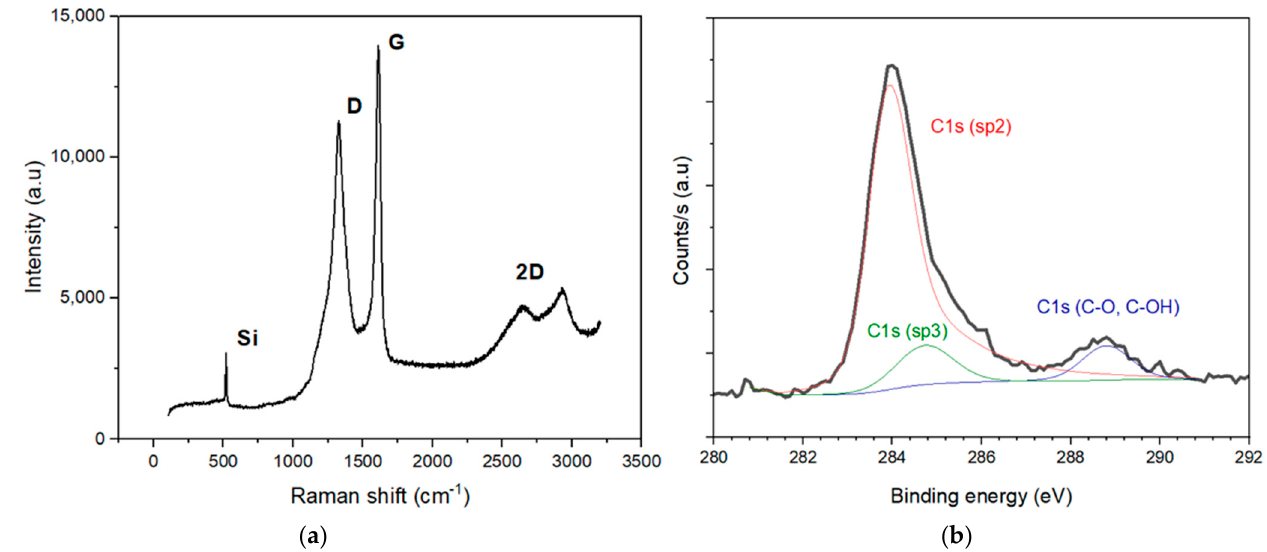
Figure 6. Spectroscopy analyses: ( a ) Raman spectrum of G-PSi-8 and ( b ) XPS analysis of G-PSi-8. XPS analyses were carried out to provide information on the presence of an oxide on the surface after graphene deposition. The XPS analysis (monochromatic source, K α Al (1486.6 eV), with a detection energy resolution of less than 0.1 eV) was performed on five different points. A representative spectrum is presented in Figure 6b. All the spectra show the same trend. First, it shows that the carbon coating is homogeneous.